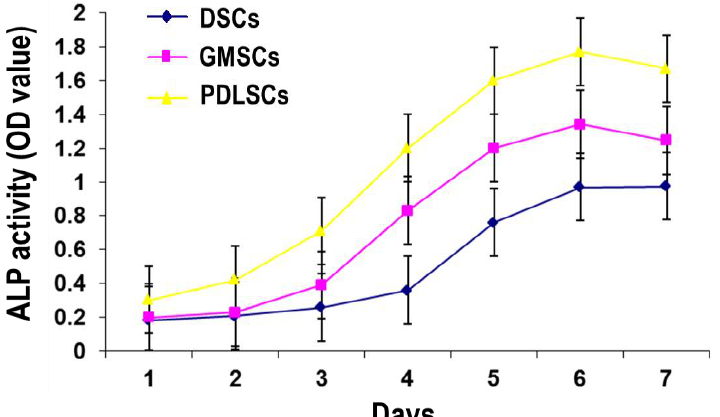
Figure 5. ALP activity of GMSCs, PDLSCs and DSCs (P3) after one to seven days of osteogenic